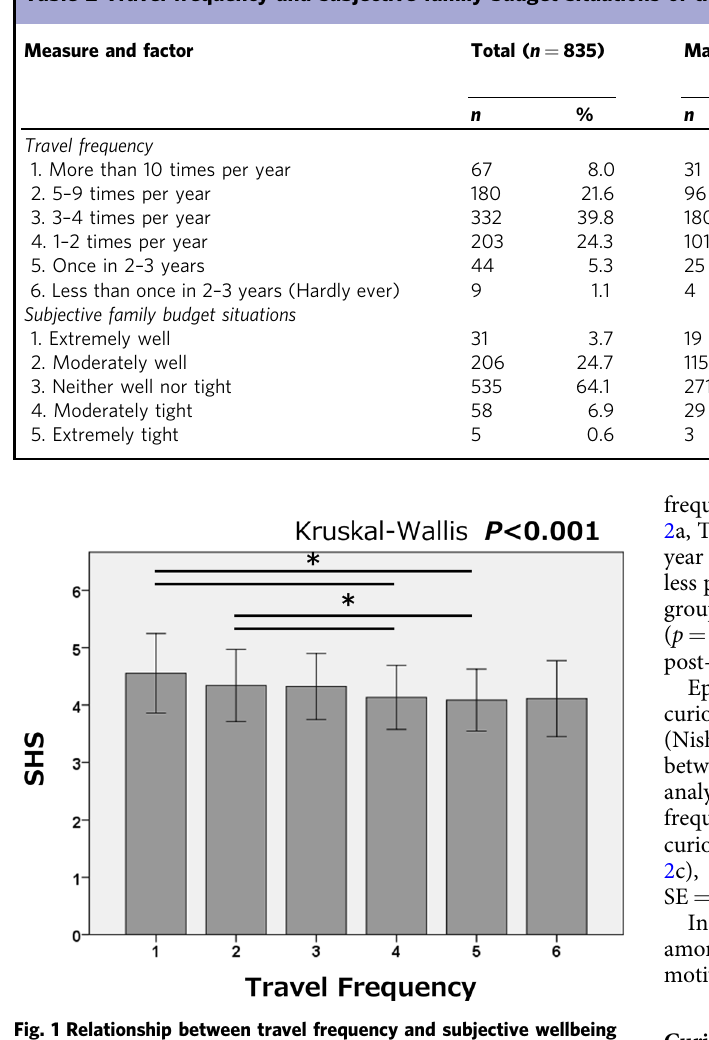
subjective wellbeing, we conducted a nonparametric test to between travel frequency groups (testing Hypothesis 1).